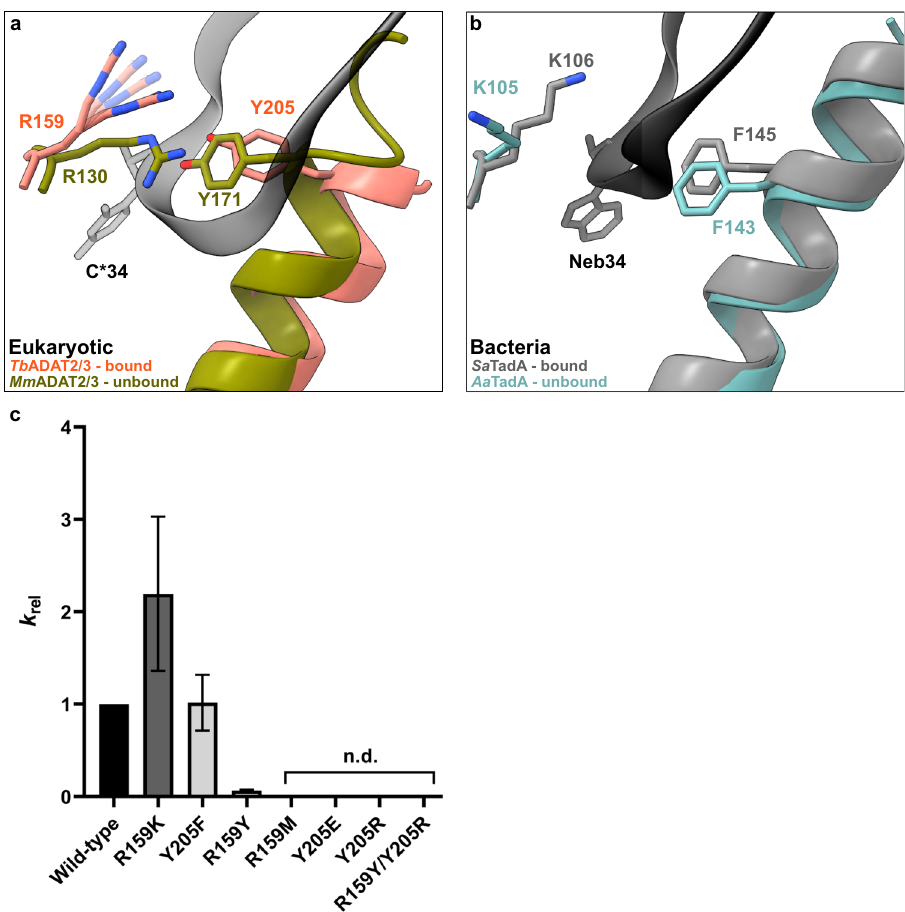
Fig.3|ThetRNAanticodonlooppassesthroughamolecularRY-gateinADAT2. a Superposition of the tRNA-bound gate in Tb ADAT2/3 and the apo-gate in Mm A- DAT2/3 (PDB: 7NZ7). The side chain of R159 Tb ADAT2 is represented as fl exible due to its poor side chain density. b The corresponding positions in bacteria deaminase TadA, RNA bound versus unbound (PDB: 2B3J and 1WWR, respectively). c Fold